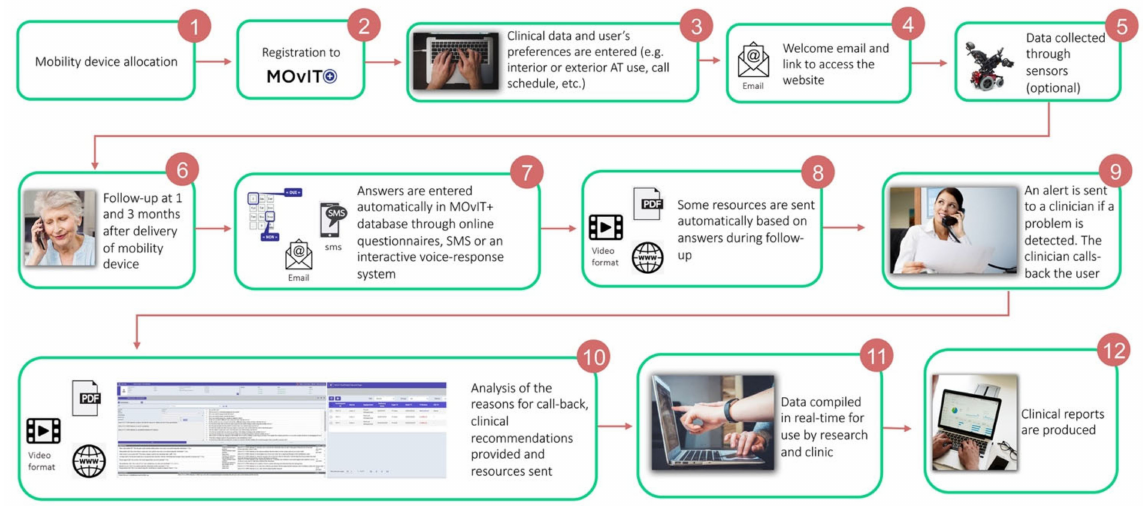
Figure 3. Program